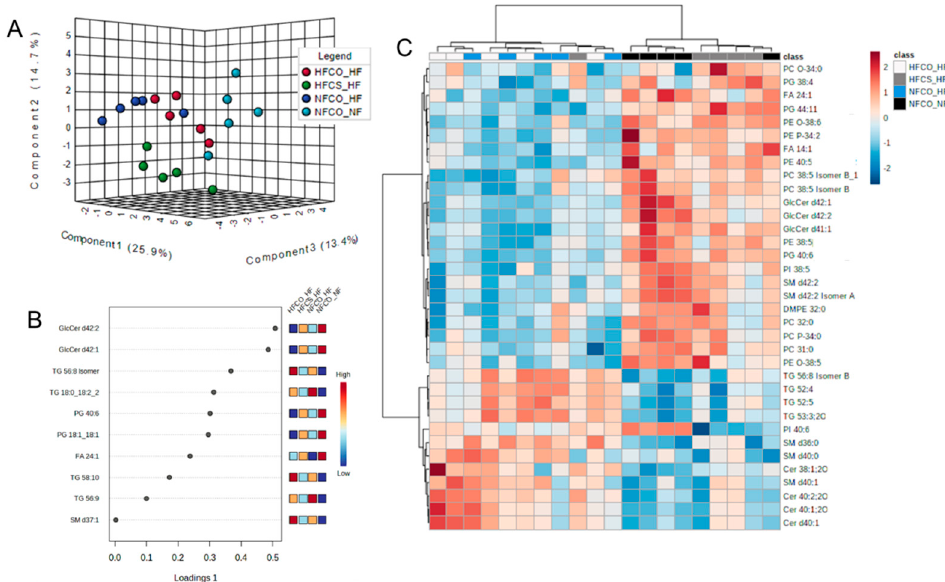
Figure 4. Lipidomics of male offspring livers after 6-week post-weaning HF feeding. ( A ) Sparse partial least squares discriminant analysis (sPLS-DA) scores plot of liver samples. ( B ) Loadings plots of lipids that contributed to differences among groups. ( C ) Heatmap of lipids that differed among groups generated from Univariate ANOVA results with Euclidean distance measure and Ward clustering method (FDR-adjusted p < 0.05). CO, untreated control without choline supplement; CS, choline- supplemented; HF, high-fat; NF, normal-fat; PC, phosphatidylcholine; PE, phosphatidylethanolamine; PG, phosphatidylglycerol; PI, phosphatidylinositol; Cer, ceramide; GlcCer, glucosylceramide; SM, sphingomyelin; DMPE, dimethylphosphatidylethanolamine; O-, ether linked fatty acid moiety. There were also significant differences in the relative abundance of other complex lipid species: PEs, PCs and sphingolipids with LCFAs and VLCFAs (Figure 4C). VLCFA are fatty acids greater than 22 carbons in length. Nervonic acid (FA 24:1), a VLCFA, had greater relative abundance in the HFCS-HF versus HFCO-HF group ( p = 0.027, Figure 5F). VLCFA breakdown occurs in the peroxisome and is required for the synthesis of plasmalogens